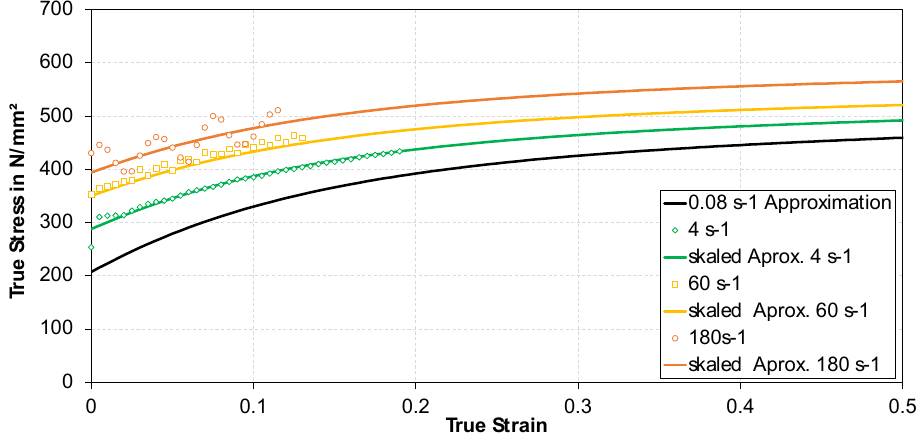
Figure 10. Approximated yield curves for actual strain rates of 0.08/s, 4/s, 60/s, and 180/s.